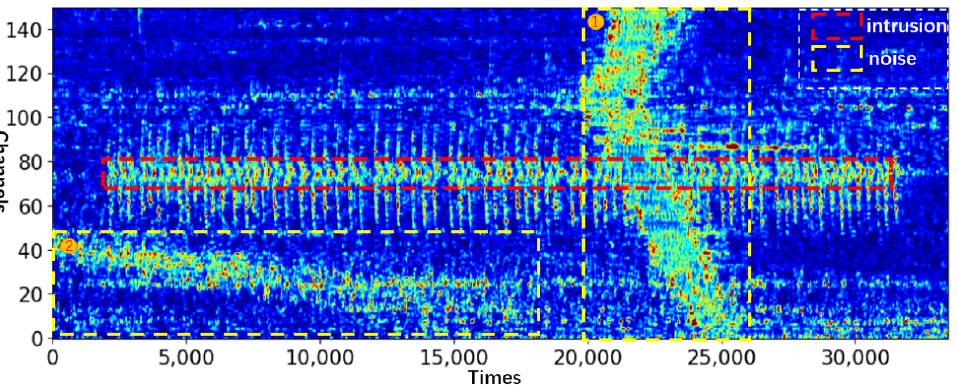
Figure 3. DAS signals of destroying the separation wall (fs = 488 HZ).